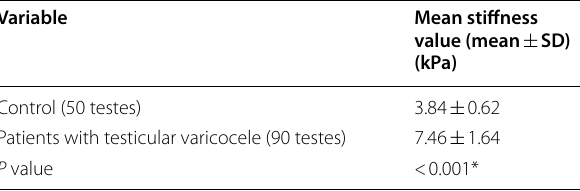
The patient group was divided into two subgroups: group (A) and group (B). Group (A) involved patients with testicular varicocele and normal total sperm count (34 testes in 15 patients with bilateral varico- cele and 4 patients with unilateral Lt. varicocele), while group (B) involved patients with testicular vari- cocele and oligospermia (56 testes in 25 patients with bilateral varicocele and 6 patients with unilateral Lt.